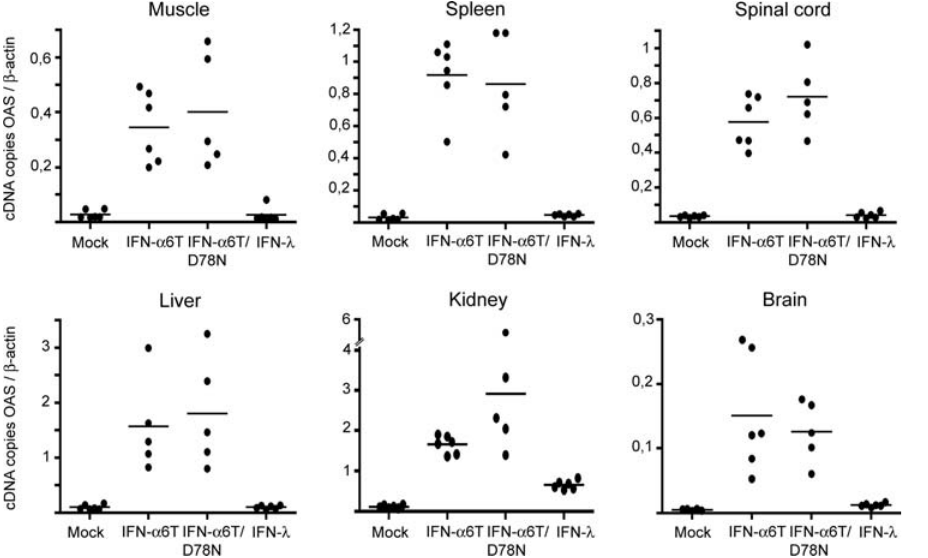
Figure 4. OASl2 expression in different tissues after electroinjection of plasmids coding for IFN- a or IFN- l . OASl2 transcripts detected by real-time RT-PCR, 7 days after electroinjection of plasmid coding for MuIFN- a 6T, MuIFN- a 6T/D78N, MuIFN- l 3 or the empty vector (mock), in 7 week-old FVB/N mice. Results are expressed as OASl2 cDNA copies per b -actin cDNA copy. Graphs present results for individual mice and the mean for each group, for one representative experiment.